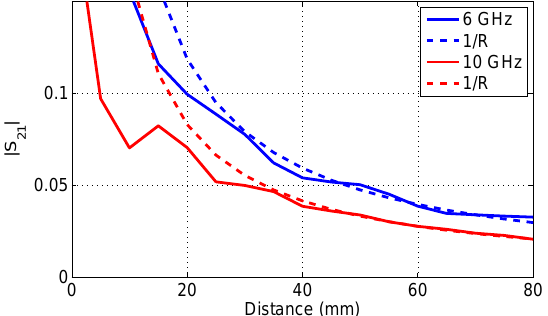
Figure A1. Power roll-off as a function of distance to depict the characteristics of far-field